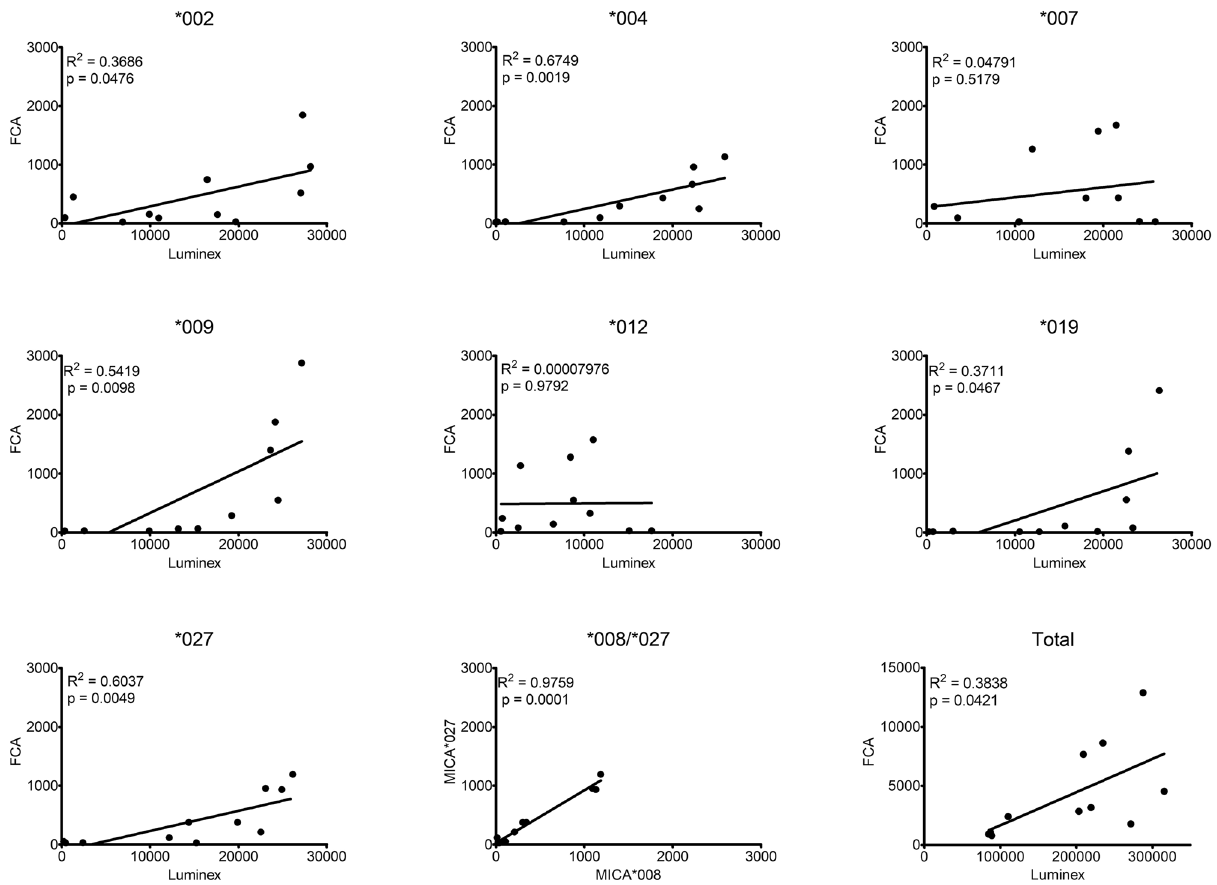
Figure 5. Correlation of total and each MICA allele response for FCM and Luminex method using 11 positive sera. The total is represented by the sum of the responses of the included alleles for each assay. Correlation was analyzed only for MICA alleles in common for both